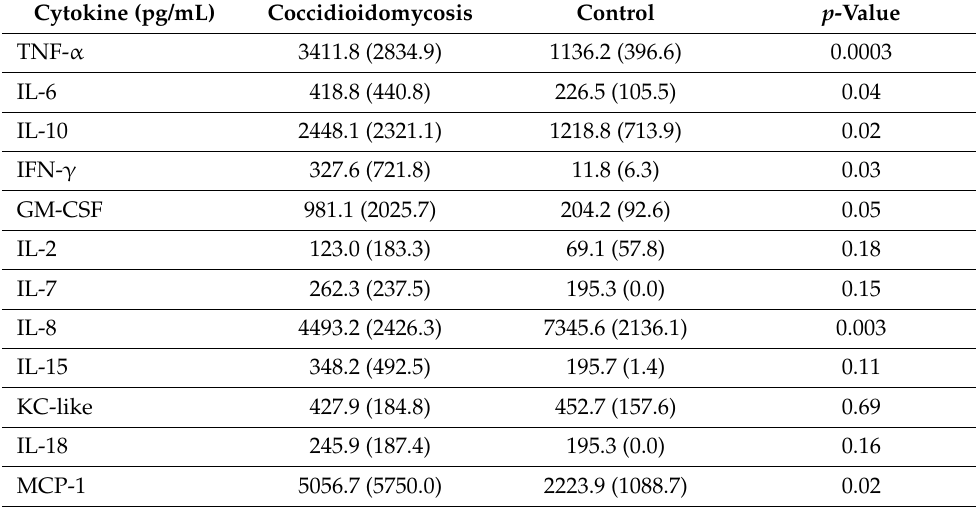
Table 4. Comparison of rCTS1 antigen-stimulated supernatant cytokine concentrations in 28 dogs with coccidioidomycosis and 10 healthy controls. Data presented as mean and standard deviation.